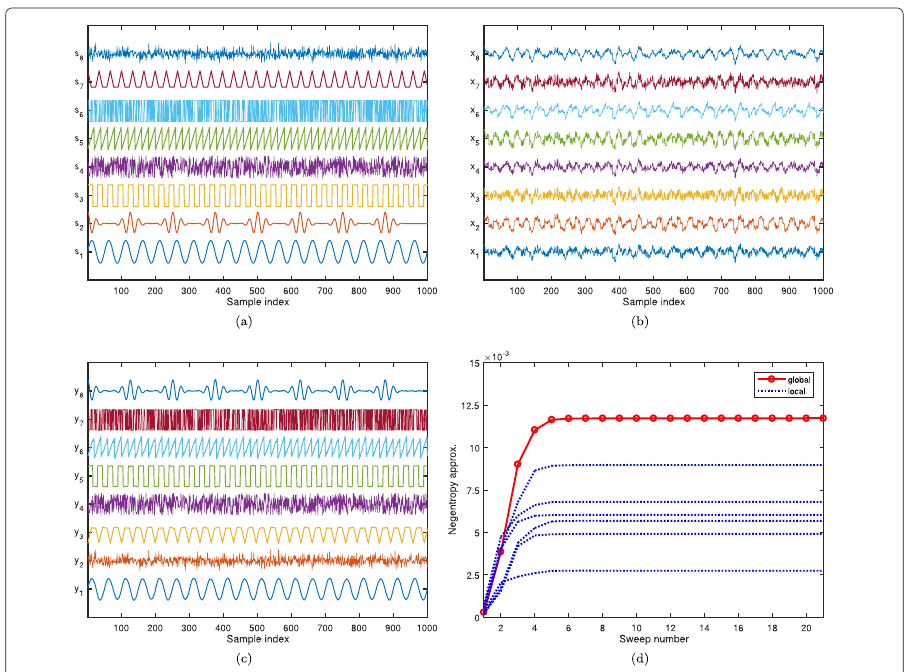
Fig.2 Demonstrationofsourceextractionusingtheproposedmethod. a Sourcesignals. b Observedmixtures of the source signals. c Estimates of the source signals. d Contrast function values versus the sweep number